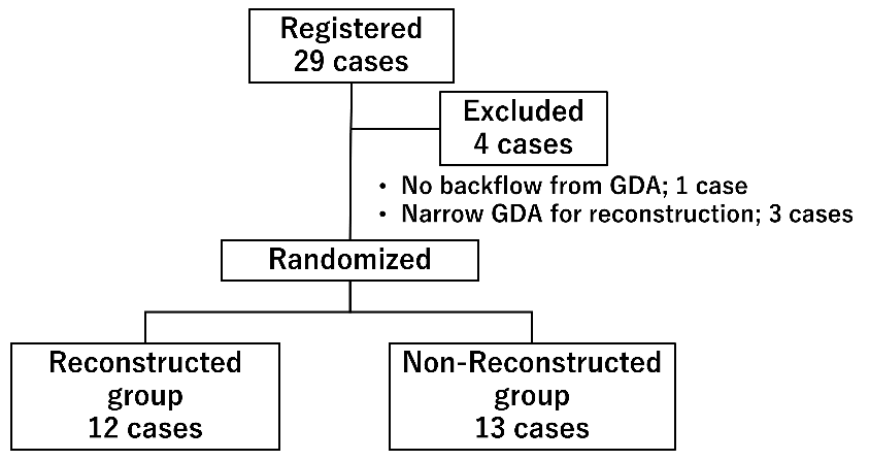
Figure 1. Study Figure 1. Study profile.